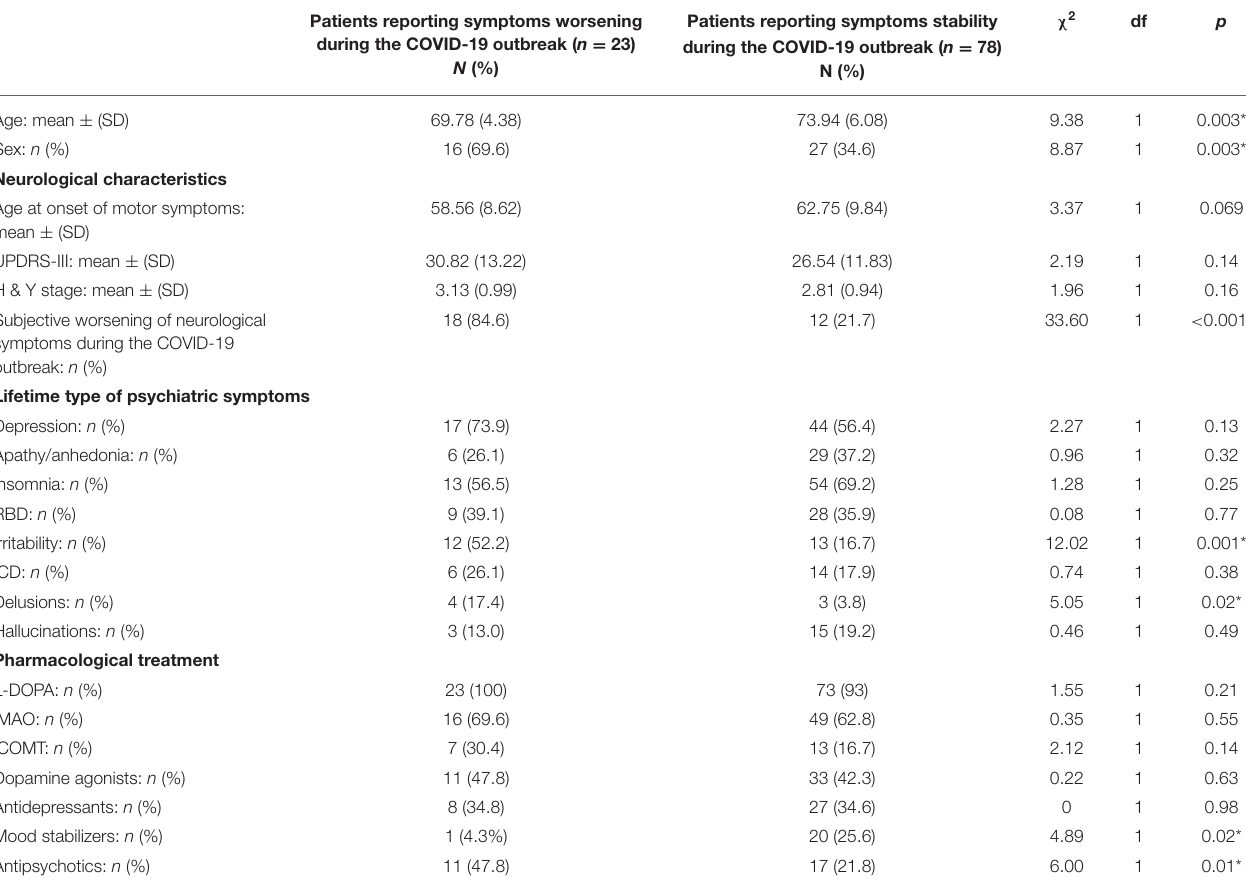
TABLE 2 | Lifetime features associated with symptoms worsening or stability during the COVID-19 outbreak.